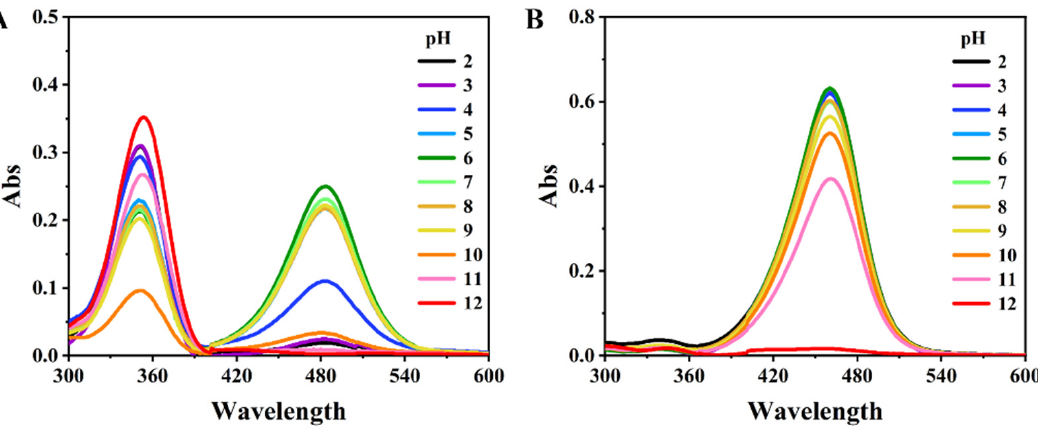
Figure 6. ( A ) UV-vis spectra of BNEA in 99% aqueous solution (V H2O :V DMSO = 99:1) at different pH and ( B ) UV-vis spectra of BNEA in 99% methanol solution (V Methanol :V DMSO = 99:1) at different pH ([BNEA] = 10 μ M).